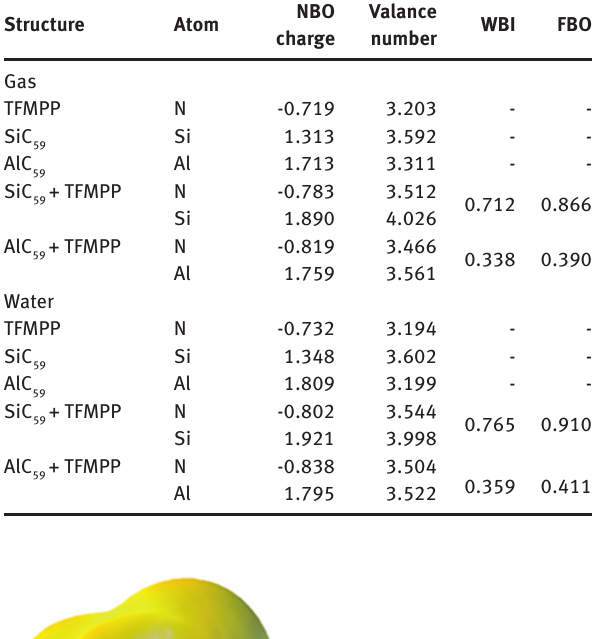
Figure 2: Optimized molecular geometry of the investigated